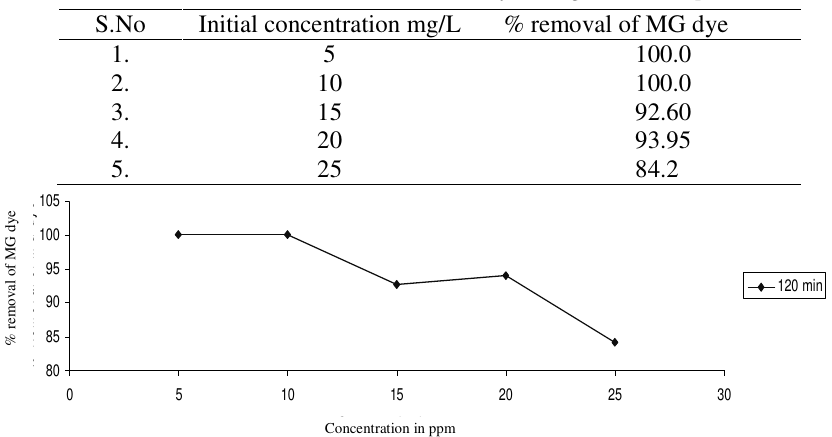
Table 1. Effect of initial concentration of MG dye using Enteromorpha at 120 min S.No